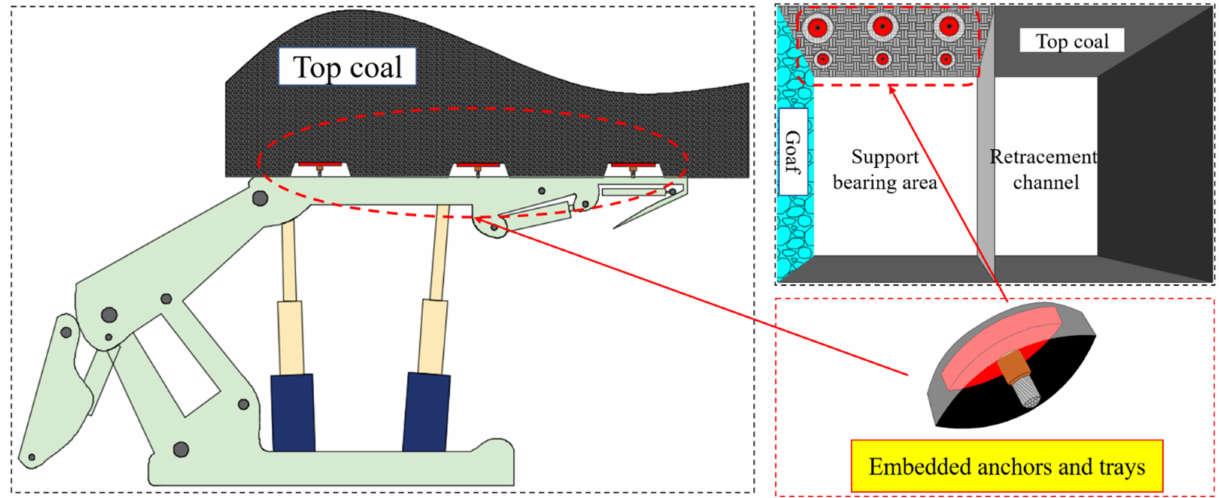
Figure 20. Schematic diagram of embedded anchorages and trays.